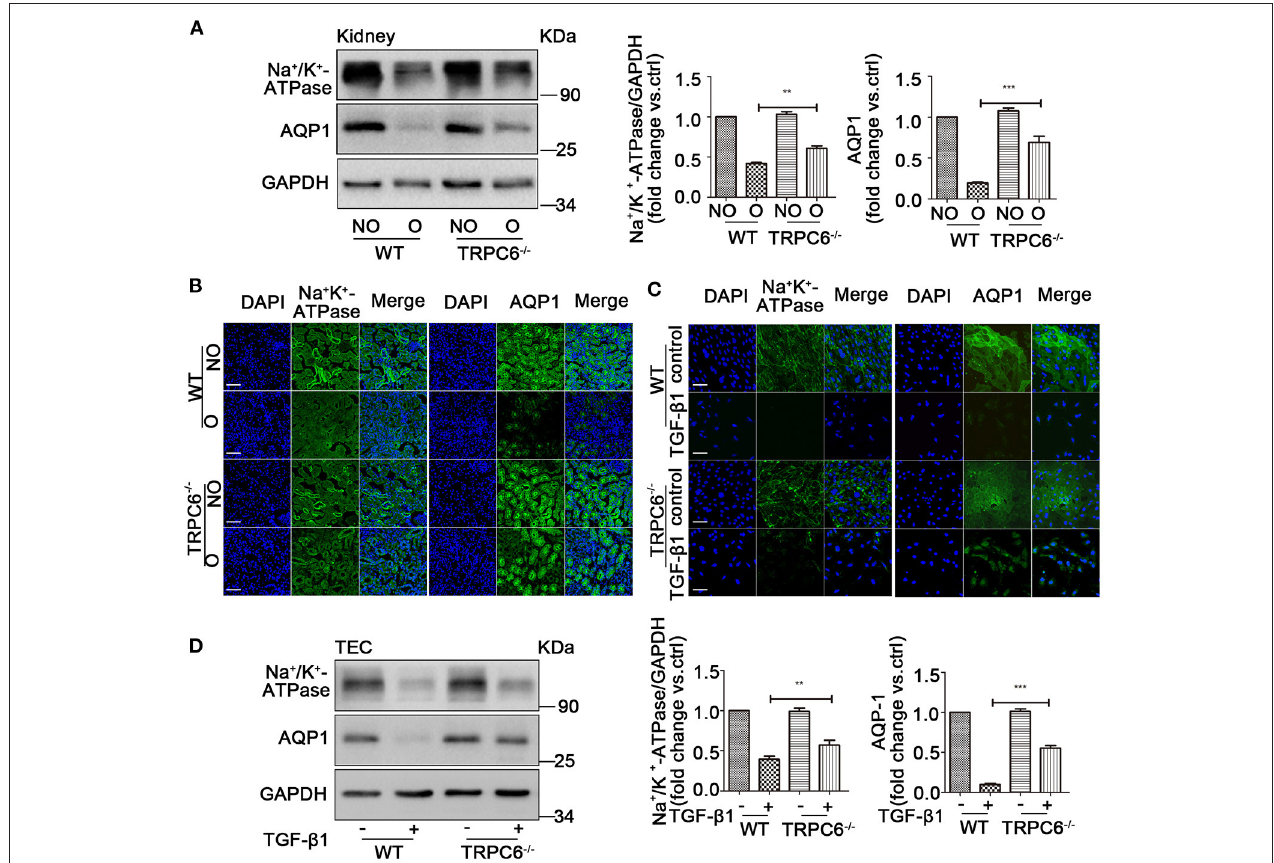
FIGURE 6 | TRPC6 knockout improves the loss of channel proteins on kidney tubulars and TEC. (A) Expression level of Na + /K + -ATPase and AQP1 in NO and O kidneys from TRPC6 knockout and WT mice on day 15 after UUO detected by western blot. Data are presented as mean ± sem, n = 3; an unpaired two-tailed t -test was used. ** P < 0.01, *** P < 0.001. (B) Expression level of Na + /K + -ATPase and AQP1 (green) as well as nuclear stain DAPI (blue) in NO and O kidneys from TRPC6 − / − and WT mice on day 15 after UUO detected by immunofluorescent staining. Scale bars, 20 µ m. (C) Expression level of Na + /K + -ATPase and AQP1